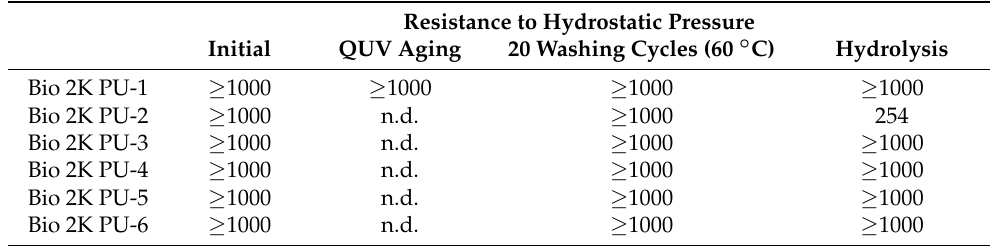
Table 5. Performance of the bio-based 2K PU coated polyester fabric. n.d.: The resistance to hydro- static pressure could not be determined since the coatings were sticky and